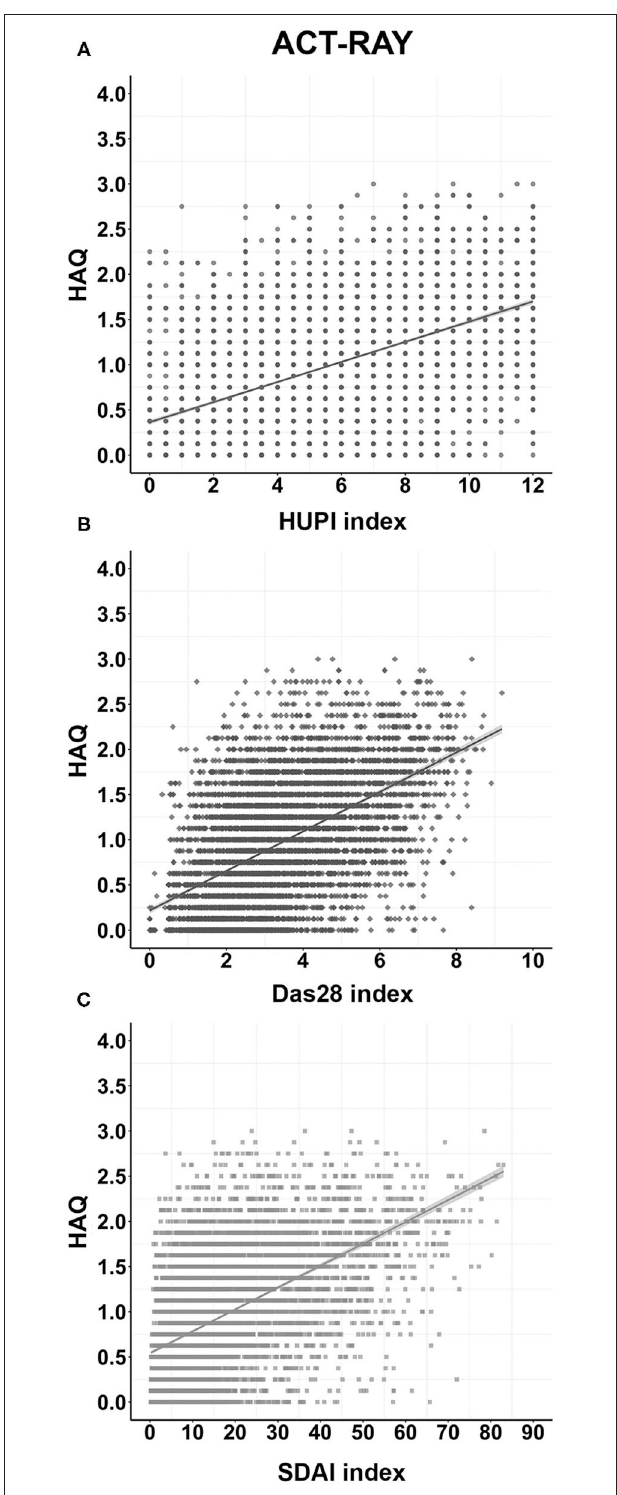
FIGURE 1 | Distribution of HAQ according to each disease activity index in the ACT-RAY study through follow-up. (A) , (B), and (C): Distributions according to the HUPI, DAS28, and SDAI index, respectively. Data are shown as dot-plots and their fitted linear prediction (line) with 95% confidence intervals (grey